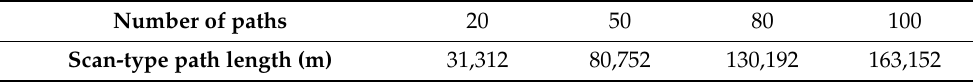
Table 2. Average comparison.